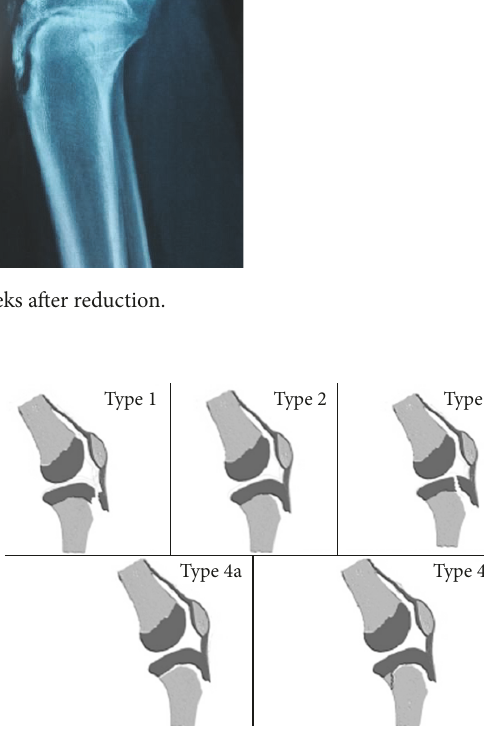
Figure 5: Classification of tibial tuberosity avulsion